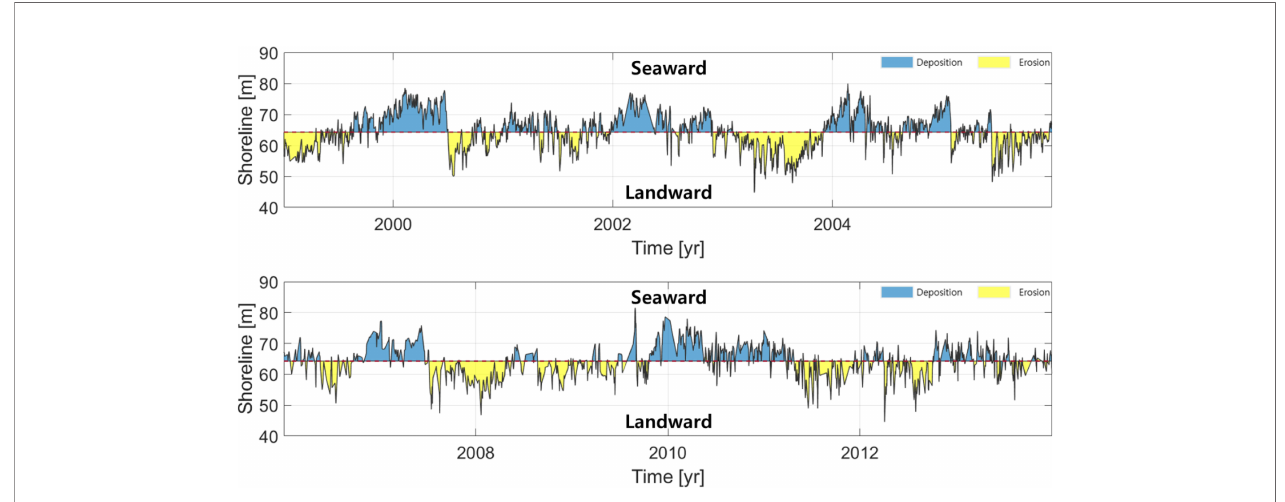
FIGURE 6 | Temporal series of shoreline change on Tairua Beach, New Zealand (Montaño et al., 2020).